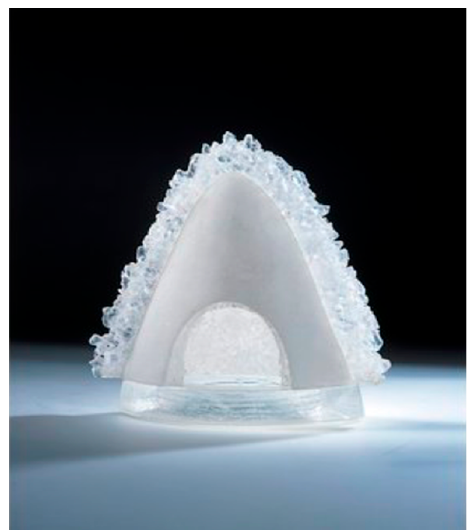
Figure 1. Matthias. 1996. Body I .